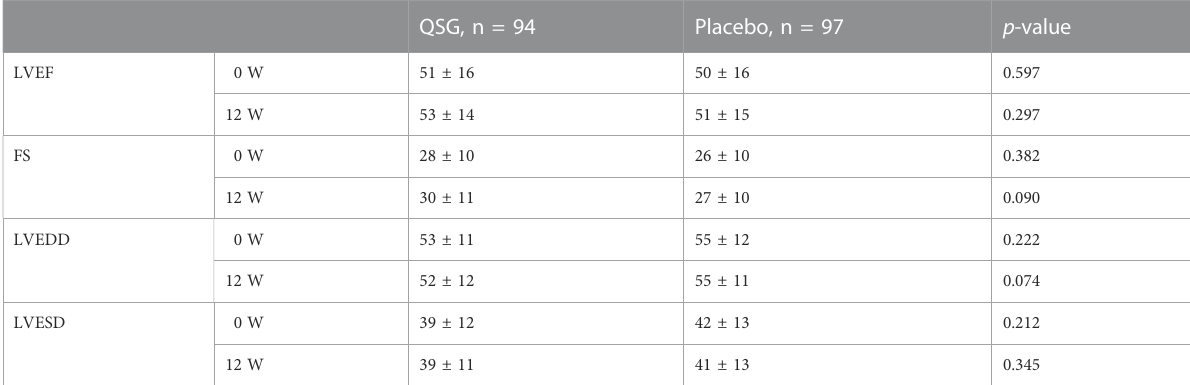
TABLE 6 Echocardiographic indices.